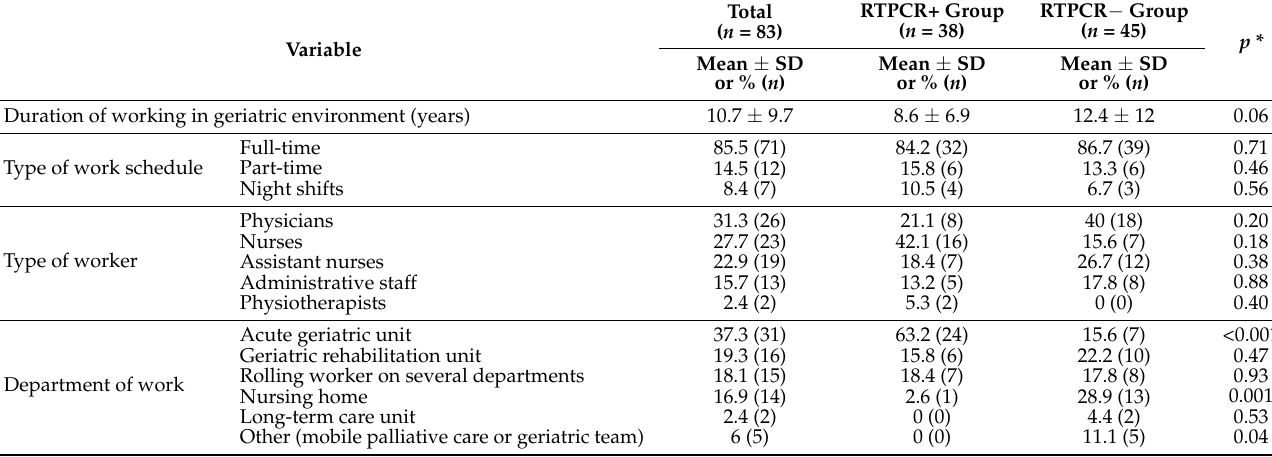
Table 3. Characteristics of work and comparison between the RTPCR+ and RTPCR −